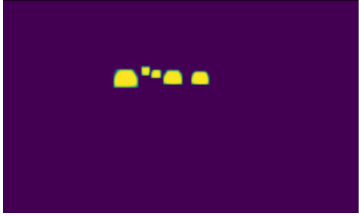
Figure 18. Output masks of detection